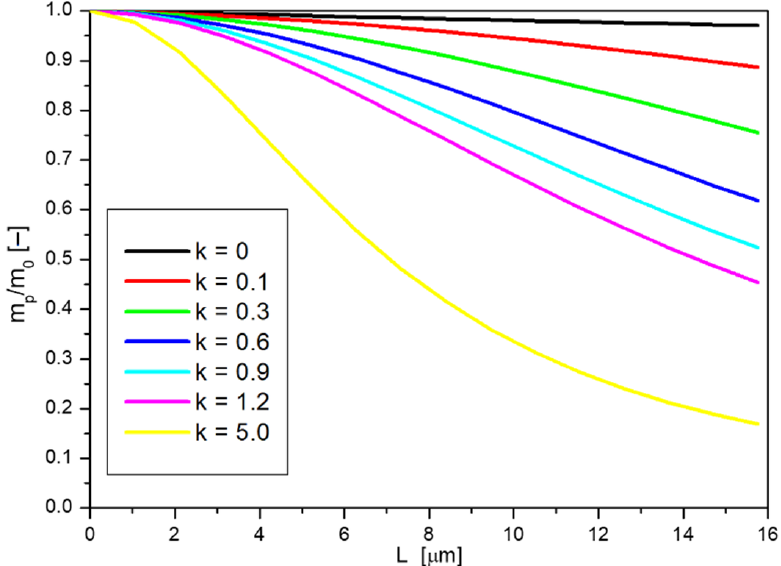
Figure 10. Dependence of dimensionless nanoparticle mass on skin film thickness at diffusion with different values of constant k.